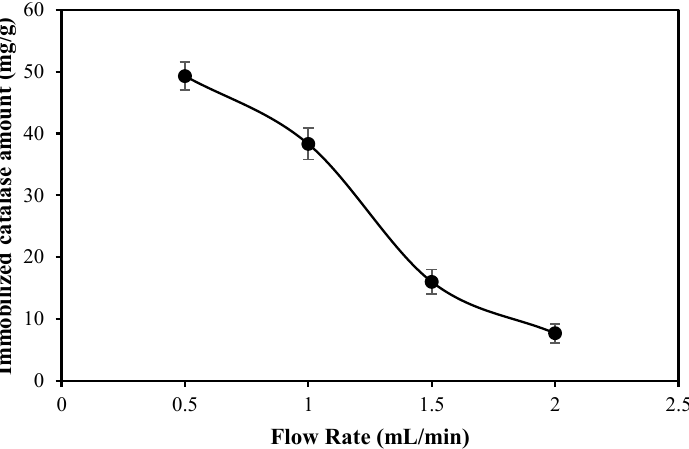
Figure 5. Effect of flow rate on catalase binding capacity of p(HEMA-co-AGE) cryogel [catalase concentration: 1.0 mg/mL in 50 mM pH 6.0 phosphate buffer; T: 25 °C].